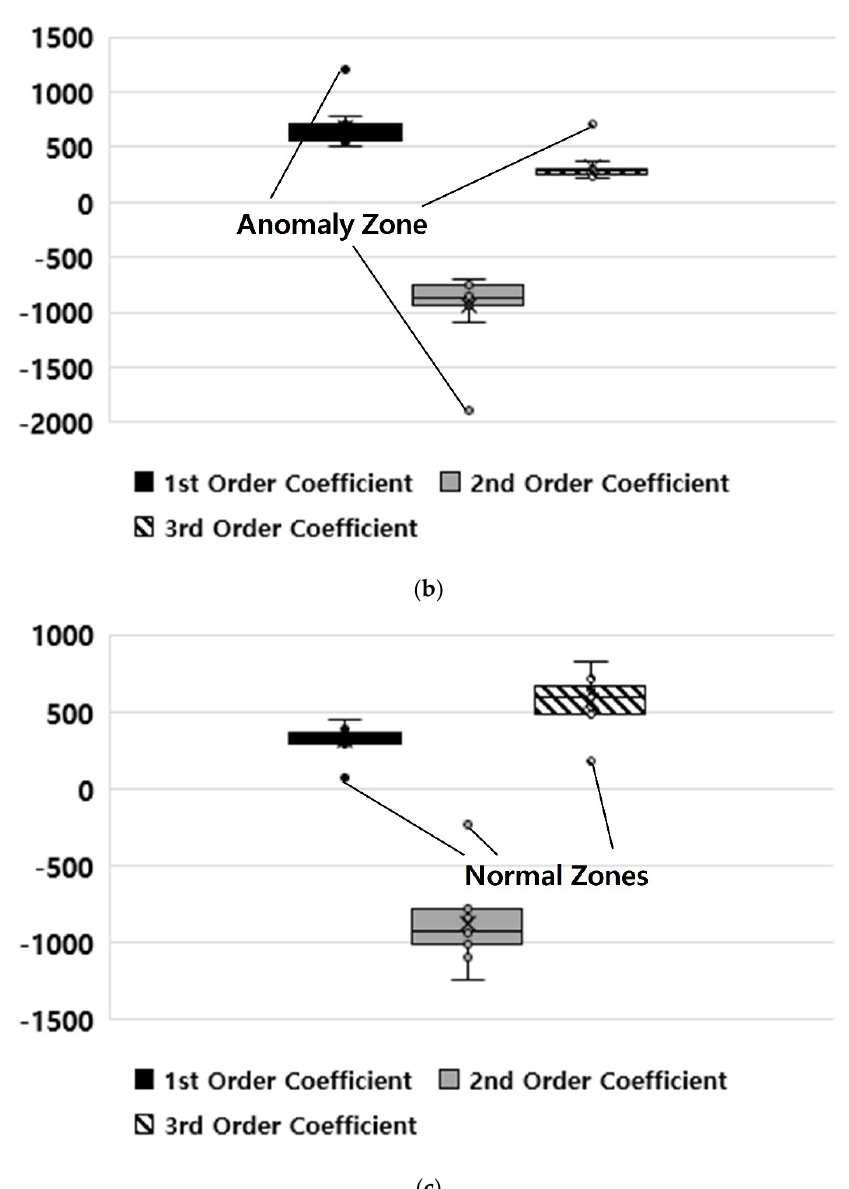
Figure 15. Verification of anomaly position by the box plot method. ( a ) Absence of anomaly zone (Section No. 1). ( b ) Existence of one small anomaly zone (Section No. 3). ( c ) Existence of more than one or a large anomaly zone (Section No. 2).